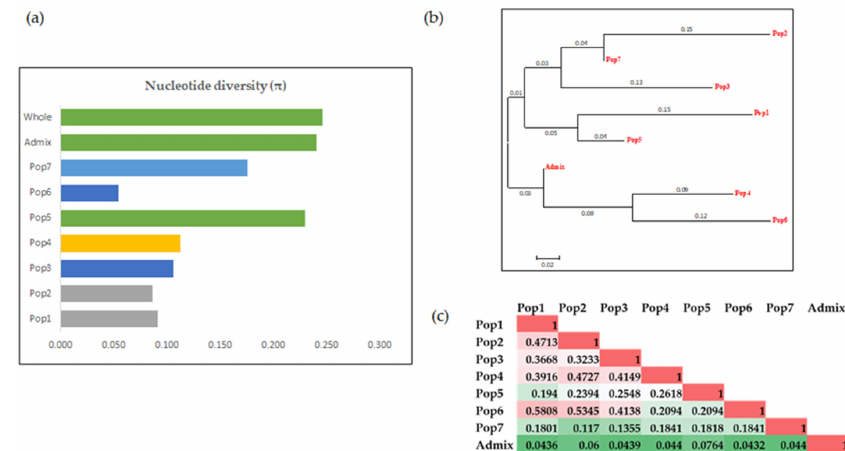
Figure 4. The genetic diversity analysis. The genetic diversity based on ( a ) the nucleotide diversity per site ( π ), ( b ) the fixation index (Fst), and ( c ) the matrix showing the pairwise Fst values between the populations.